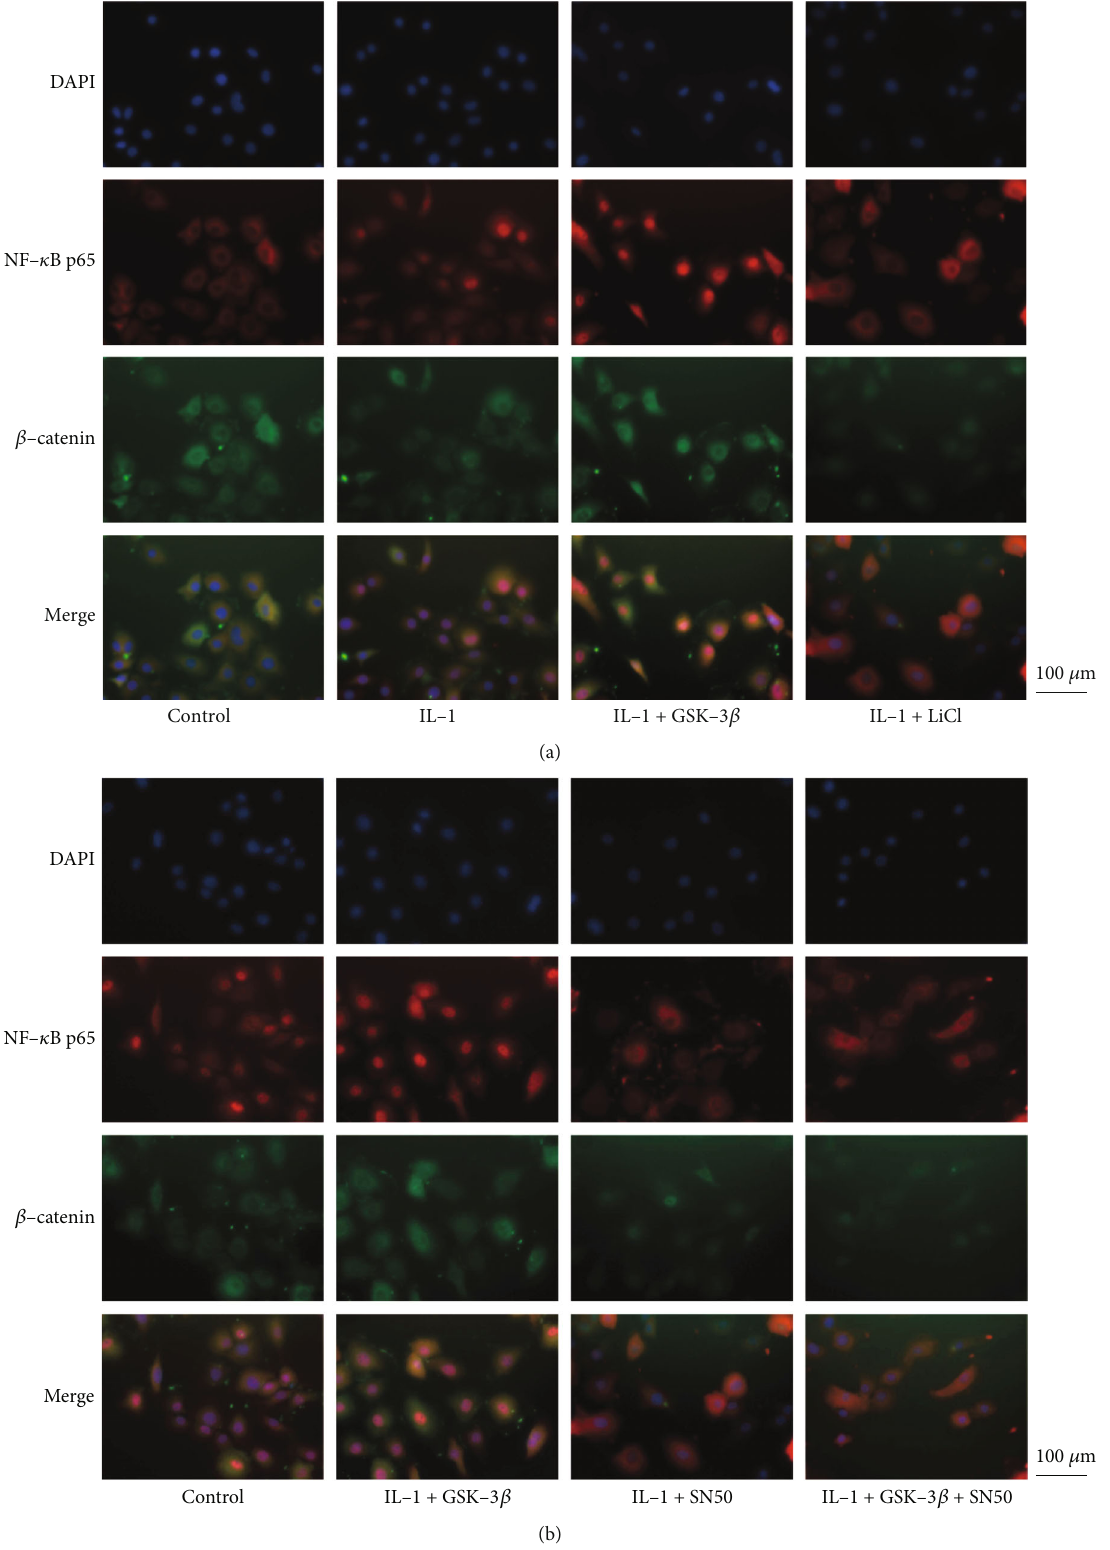
Figure 6: GSK-3 β mediates the cross-reaction between NF- κ B and β -catenin in the nucleus. Immuno fl uorescence was used to observe the distribution of NF- κ B p65 (red) and β -catenin (green). The nuclei were DAPI-stained (blue). Three independently repeated experiments were performed, and a representative image is shown. Bar = 100 μ